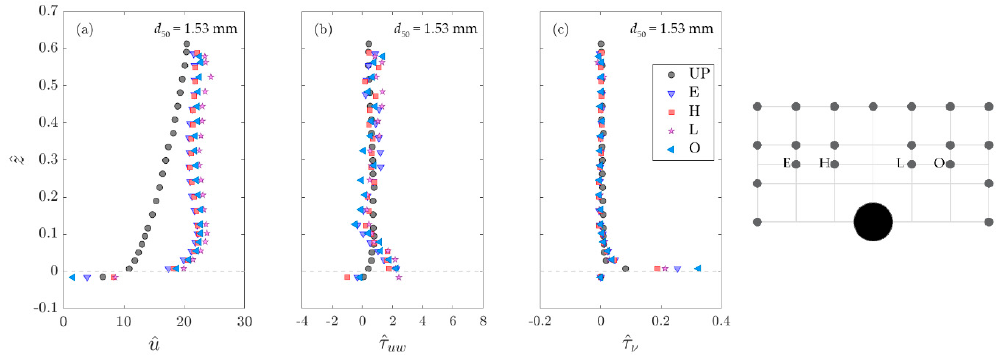
Figure 11. Vertical distributions of ( a ) dimensionless time-averaged velocity, ( b ) dimensionless Reynolds shear stress, and ( c ) dimensionless viscous shear stress measured at y = 0.5 B s in Run 1.